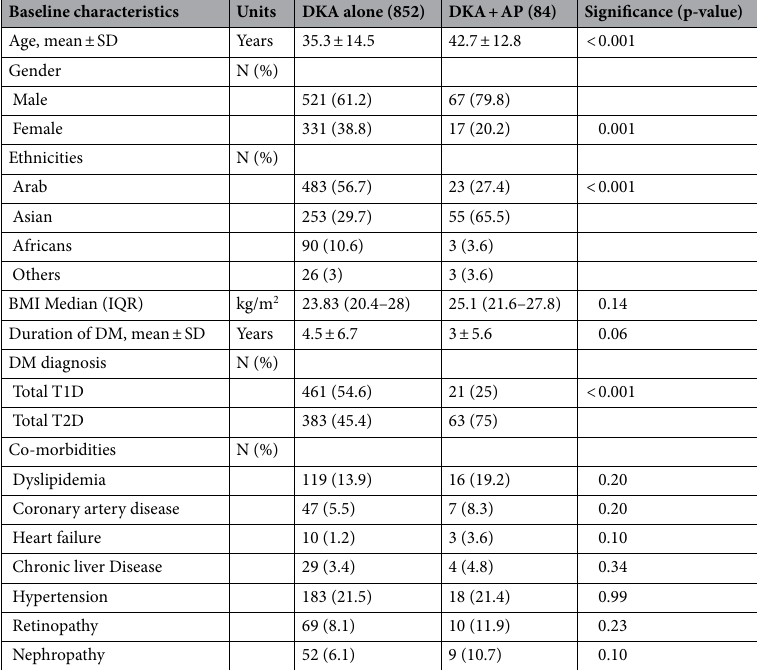
Variable Normal